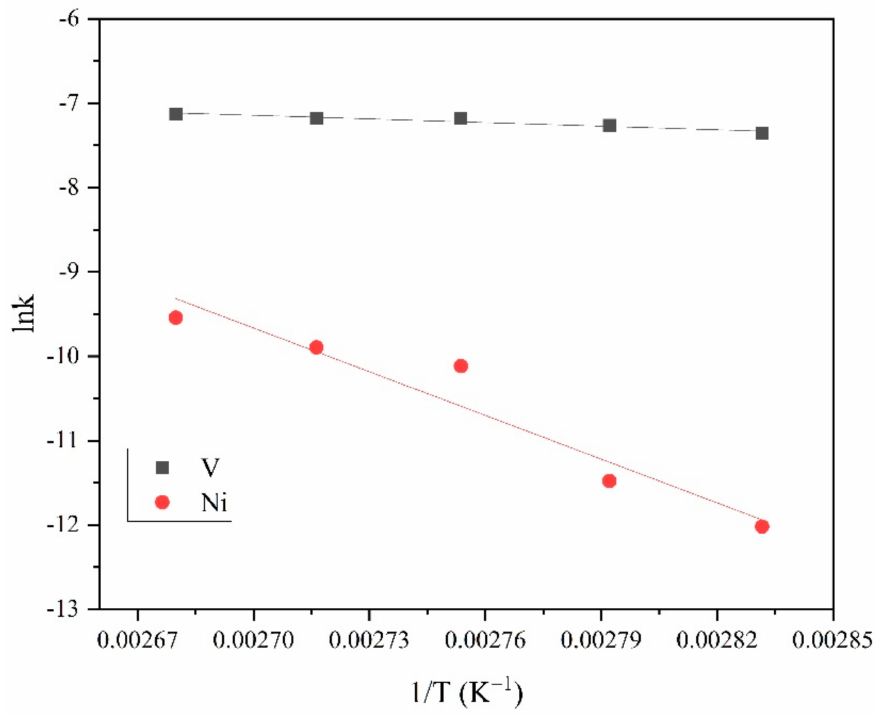
Figure 9. Linear fitting of (lnk) vs.